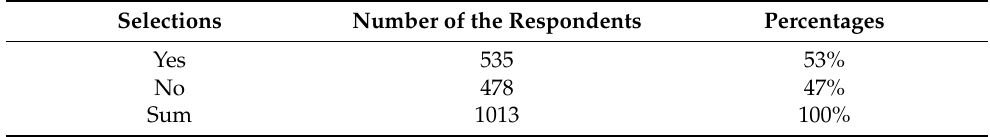
Table A5. Do you have any experiences on operating financial derivatives (single-choice